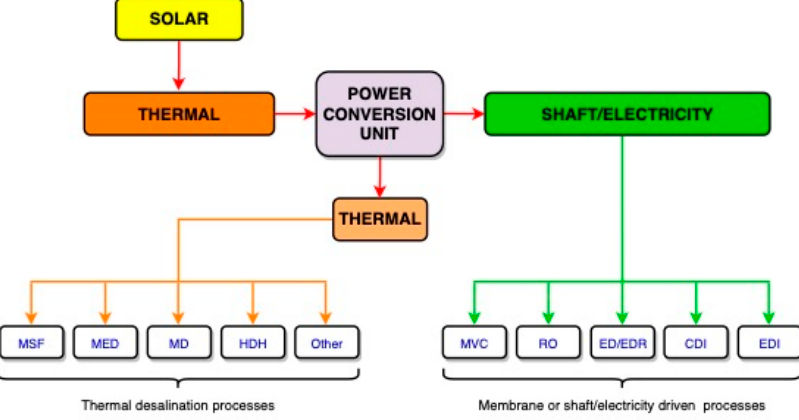
Figure 1. Possible indirect solar desalination options when a power conversion unit (power cycle) is considered as the solely final energy supply unit. MSF: multi-stage flash; MED: multi-effect distillation; MD: membrane distillation; HDH: humidification dehumidification; MVC: mechanical vapor compression; RO: reverse osmosis; ED/EDR: electrodialysis / electrodialysis reversal; CDI: capacitive deionization; EDI: electrodeionization. Adapted from [6].